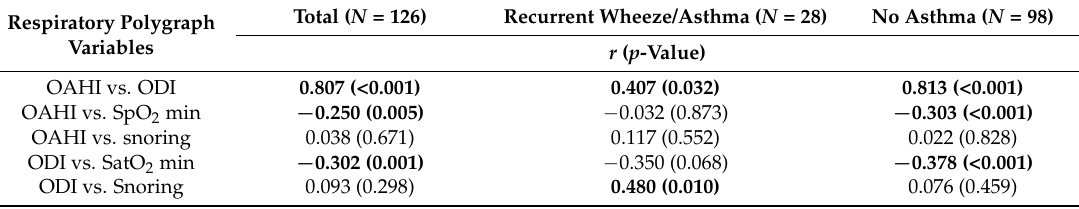
Table 3. Simple correlation analysis (Pearson’s test) of respiratory polygraphic